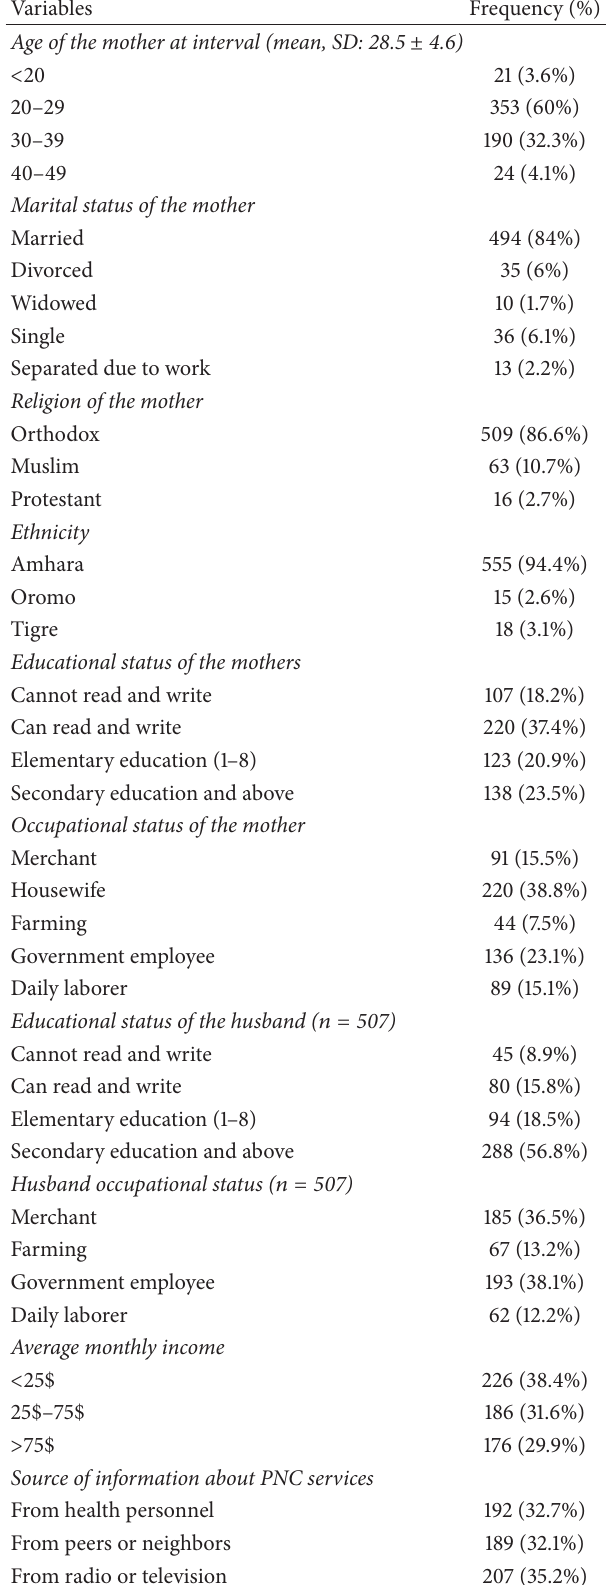
Table 1: Sociodemographic characteristics of the study participants at Debremarkos town, December 2014 ( 𝑛 = 588